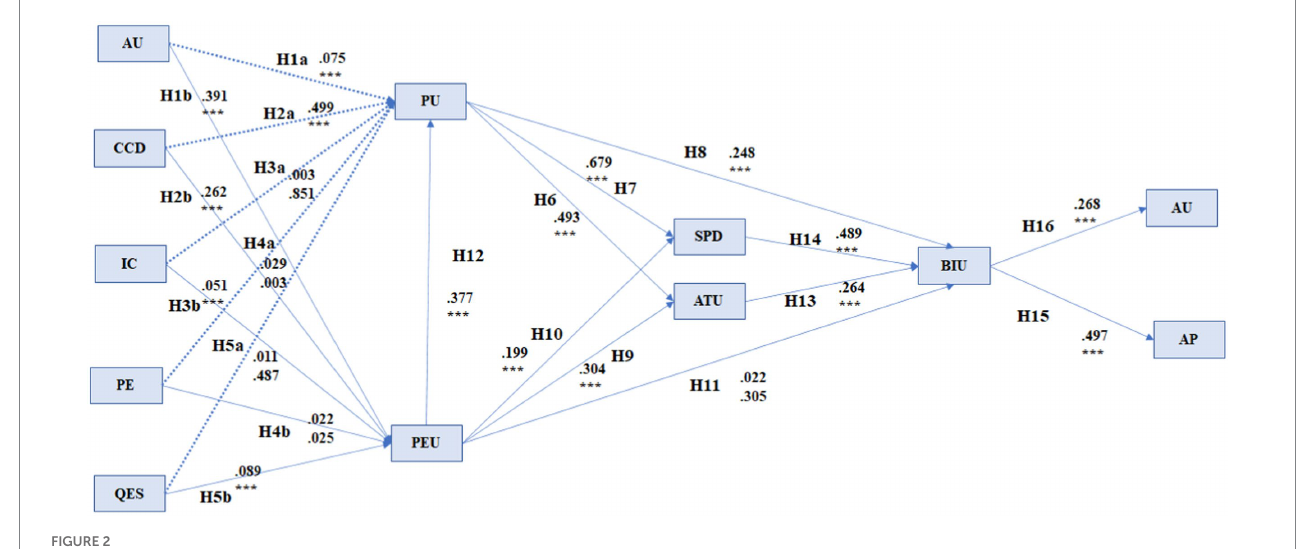
FIGURE 2 Hypothesis validation. *** p =